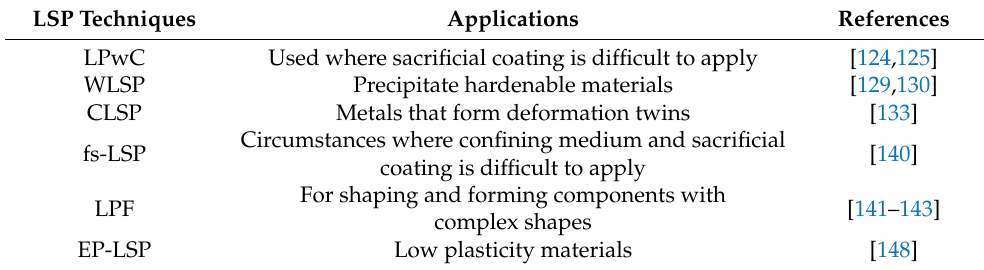
Figure 23. TEM images of dislocations in α -SiC ceramics generated by LSP: ( a ) weak-beam dark- field and ( b ) bright-field images of dislocations underneath the surface. Reproduced with permission from [149]. Copyright Elsevier, 2019. Table 5. Recent developments of LSP.